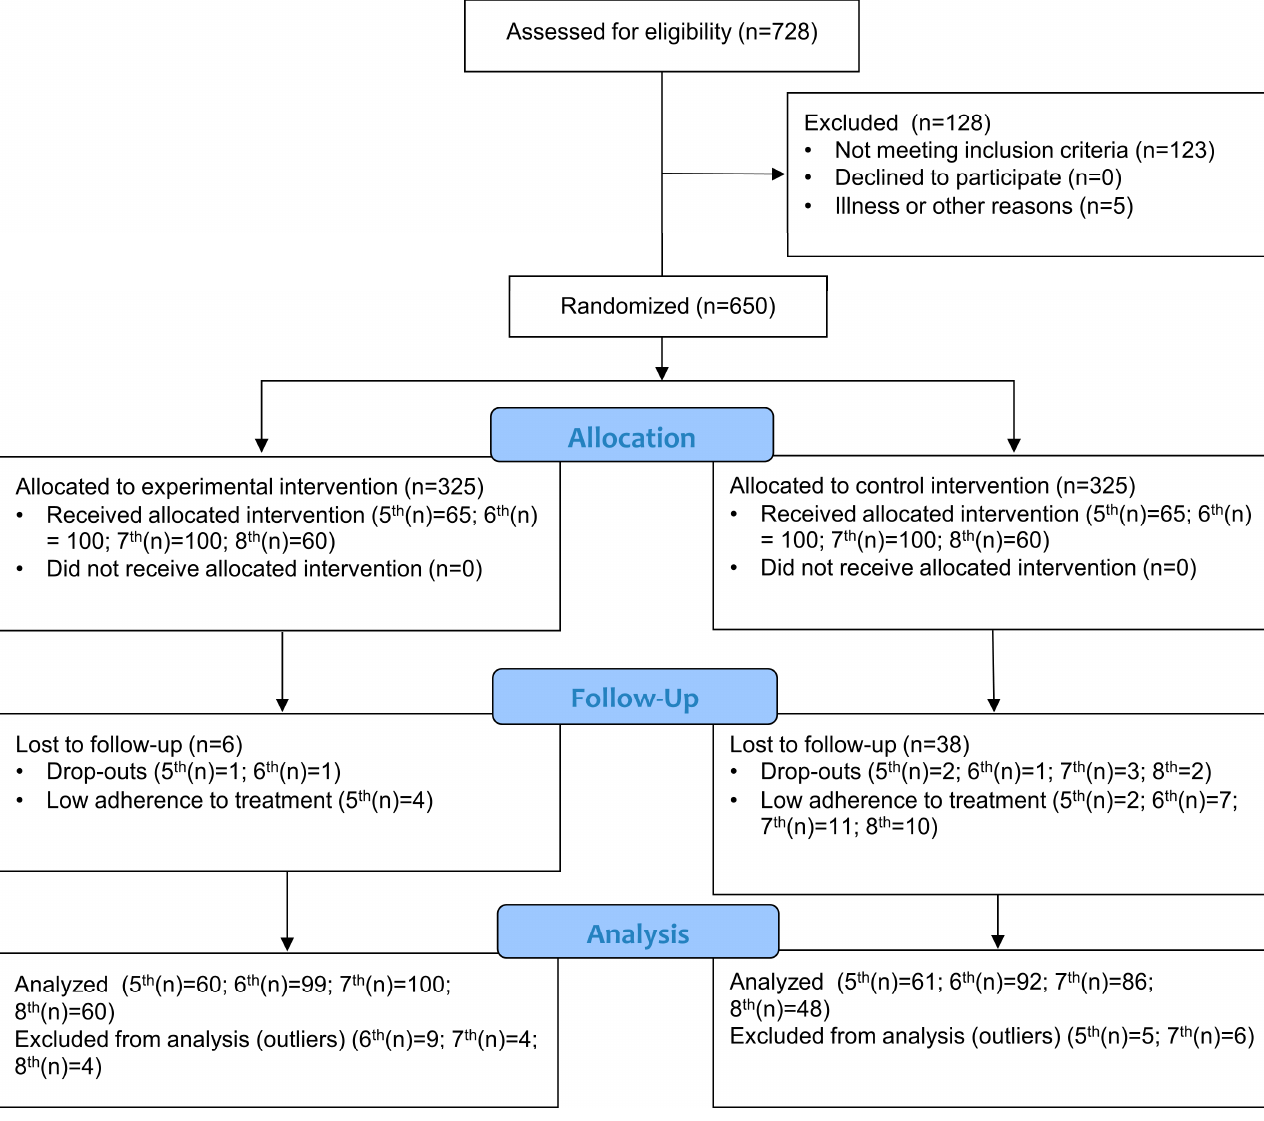
Figure 1. Flow chart diagram of subjects included in the study, randomization, and analysis.